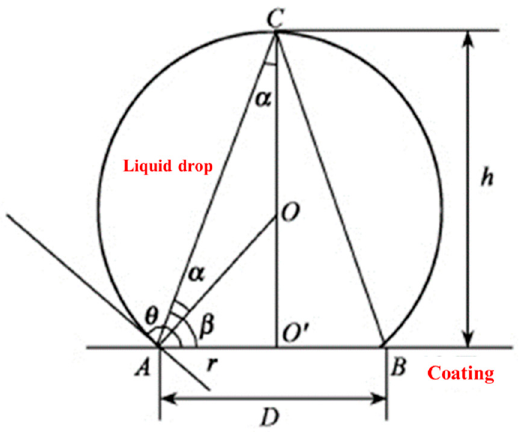
Figure 3. Principle of calculating water contact angle by measuring height method.